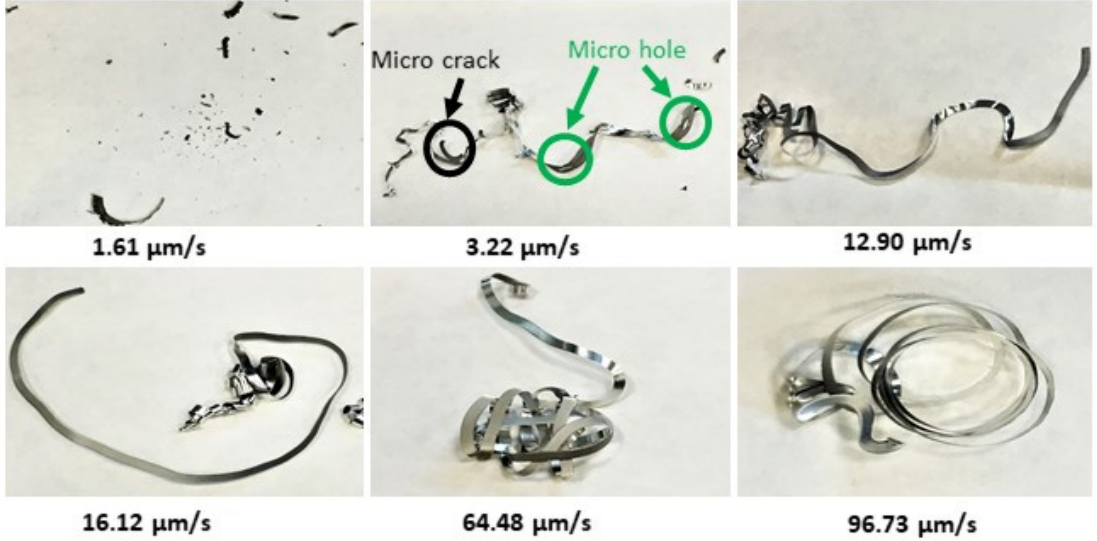
Figure 3. Micromachined chips of Al alloy produced 100 m/min (636 rpm) with various feed rates.